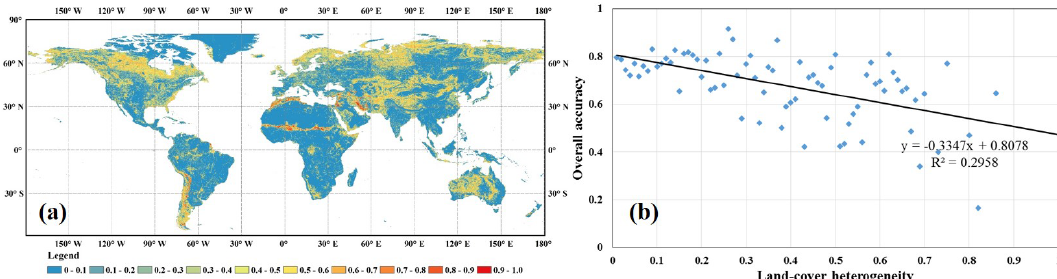
Figure 11. The land-cover heterogeneity of the GLC_FCS30 land-cover map at a spatial resolution of 0.05 ◦ , and the relationship between land-cover heterogeneity and overall accuracy using the global validation datasets.